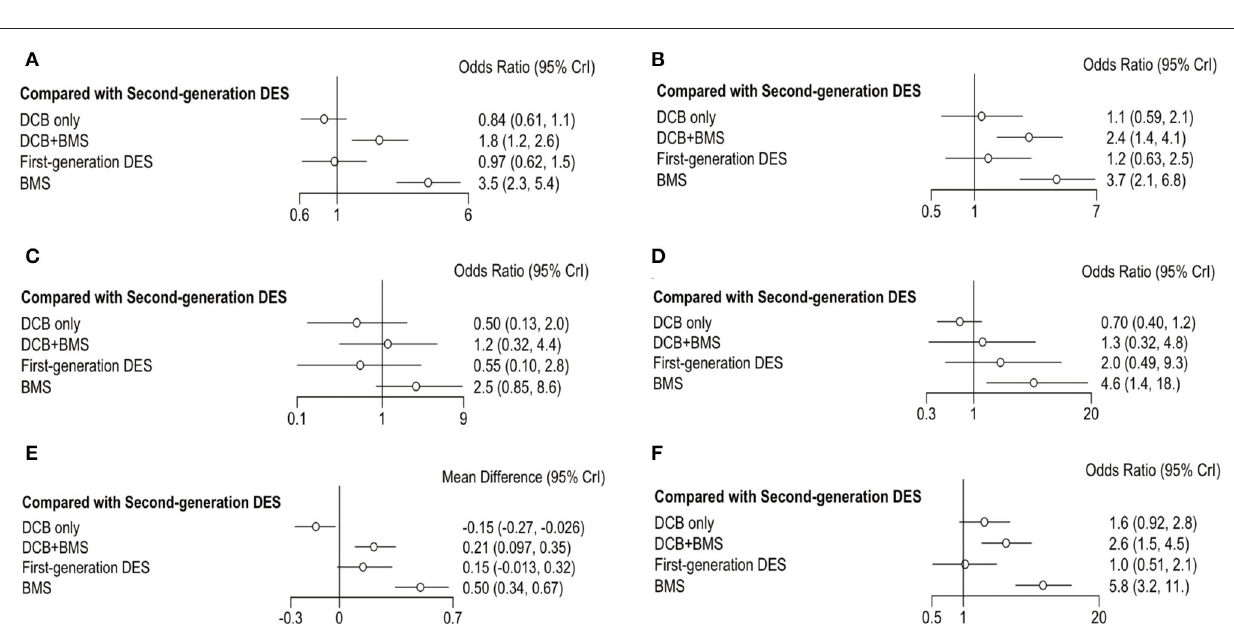
moderate and high evidence quality. However, the outcome of was compared with DCB only ( P = 0.01), BMS was compared with DCB only ( P = 0.01), and DCB + BMS was compared inconsistency was found in myocardial infarction when BMS was with the first-generation DES ( P =